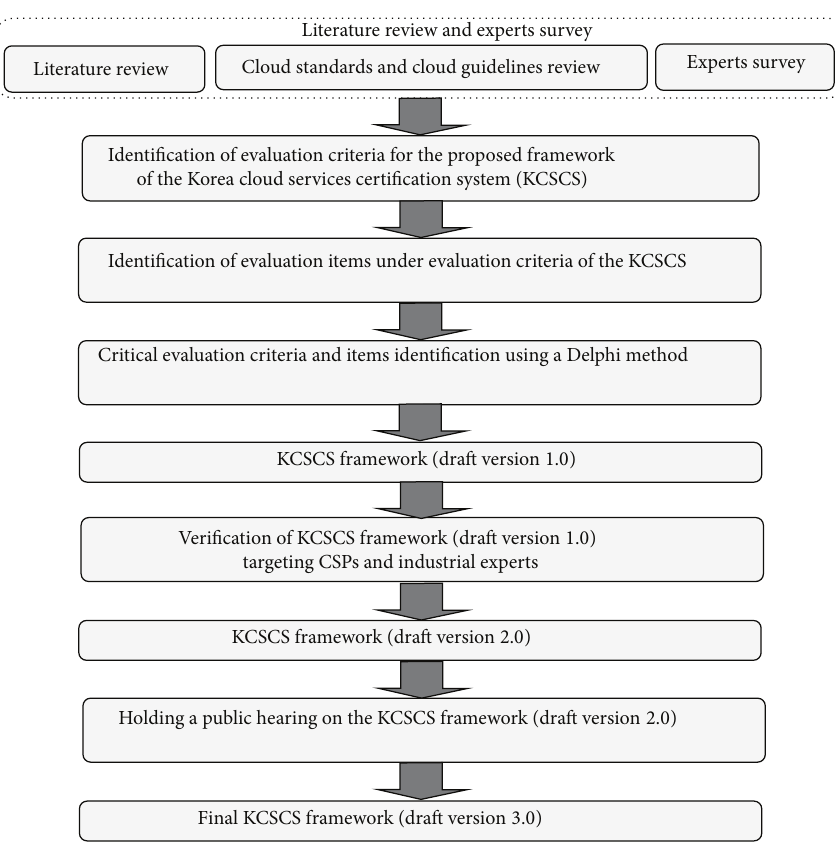
Figure 1: The development procedures of the Korea cloud service certification